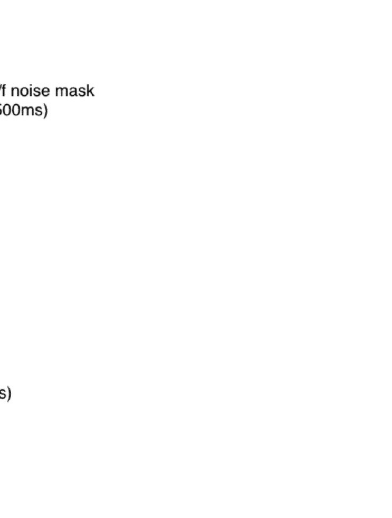
Fig 2. Data collection